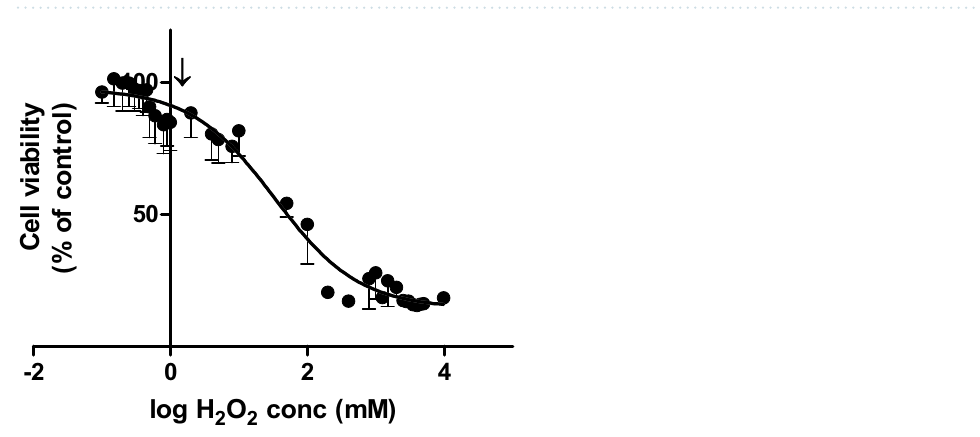
Figure 8. Cell viability of HaCaT cells in response to treatment with acidic solutions at pH values similar to pH values observed for PAS 20, compared with different dilutions of PAS 20.